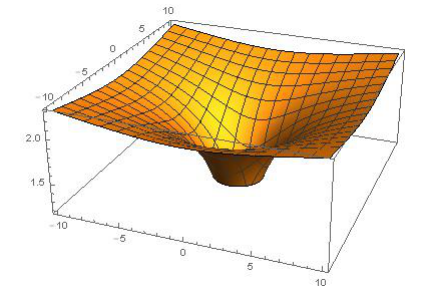
Figure 3. Invariant solution of the unperturbed equation of Equation (56) for − 10 ≤ x ≤ 10, − 10 ≤ y ≤ 10, x 2 + y 2 ≥ 1.